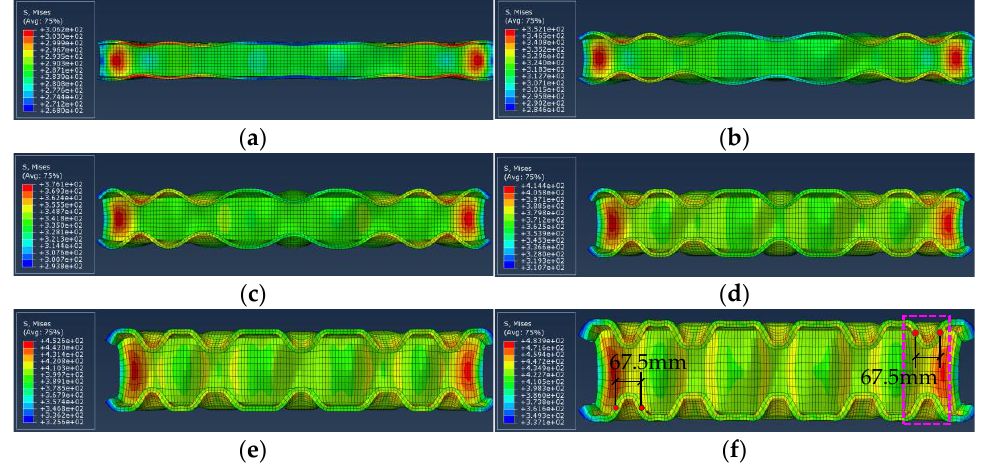
Figure 12. Buckling development of H-section steel core in compression for the third time. ( a ) ε = 0. ( b ) ε = − 0.67%. ( c ) ε = − 1.22%. ( d ) ε = − 2.07%. ( e ) ε = − 2.87%. ( f ) ε = − 3.50%.